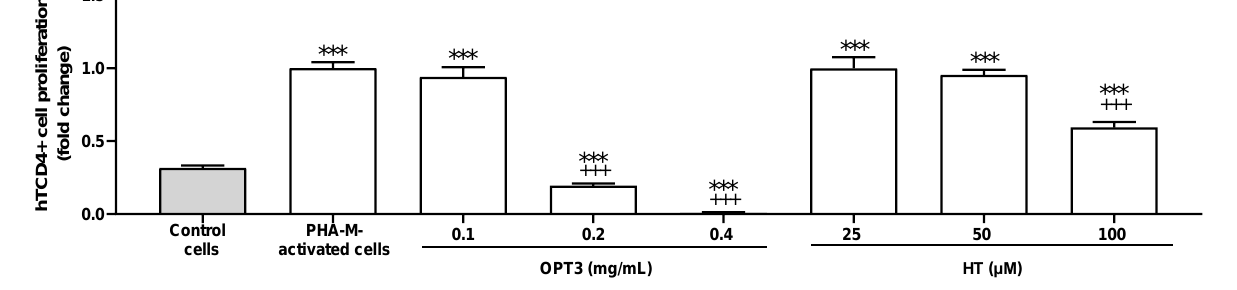
Figure 1. Effect of a selected crude OP extract (OPT3) and HT on the proliferation of PHA-M–activated hTCD4+. Cells were activated with 1% PHA-M, except for the control, and treated for 48 h with OPT3 (0.1–0.4 mg/mL), HT (25–100 μM/0.004–0.015 mg/mL) or vehicle (cell culture medium). Cell proliferation was measured with alamarBlue HS assay (n = 3). *** p -value < 0.001, compared with control (non-stimulated) cells; +++ p -value < 0.001, compared with vehicle-treated-PHA-M-activated cells.